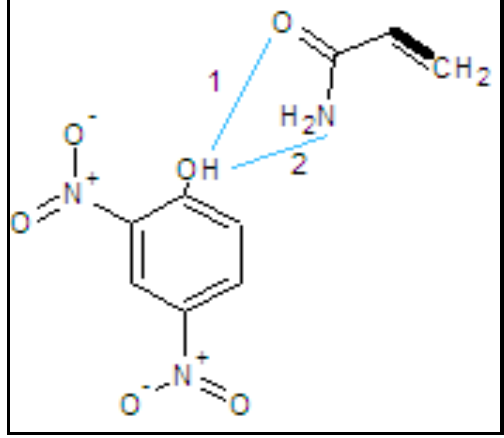
Figure 2. Proposed interaction between monomer (acrylamide)and the template (2,4-dinitrophenol).